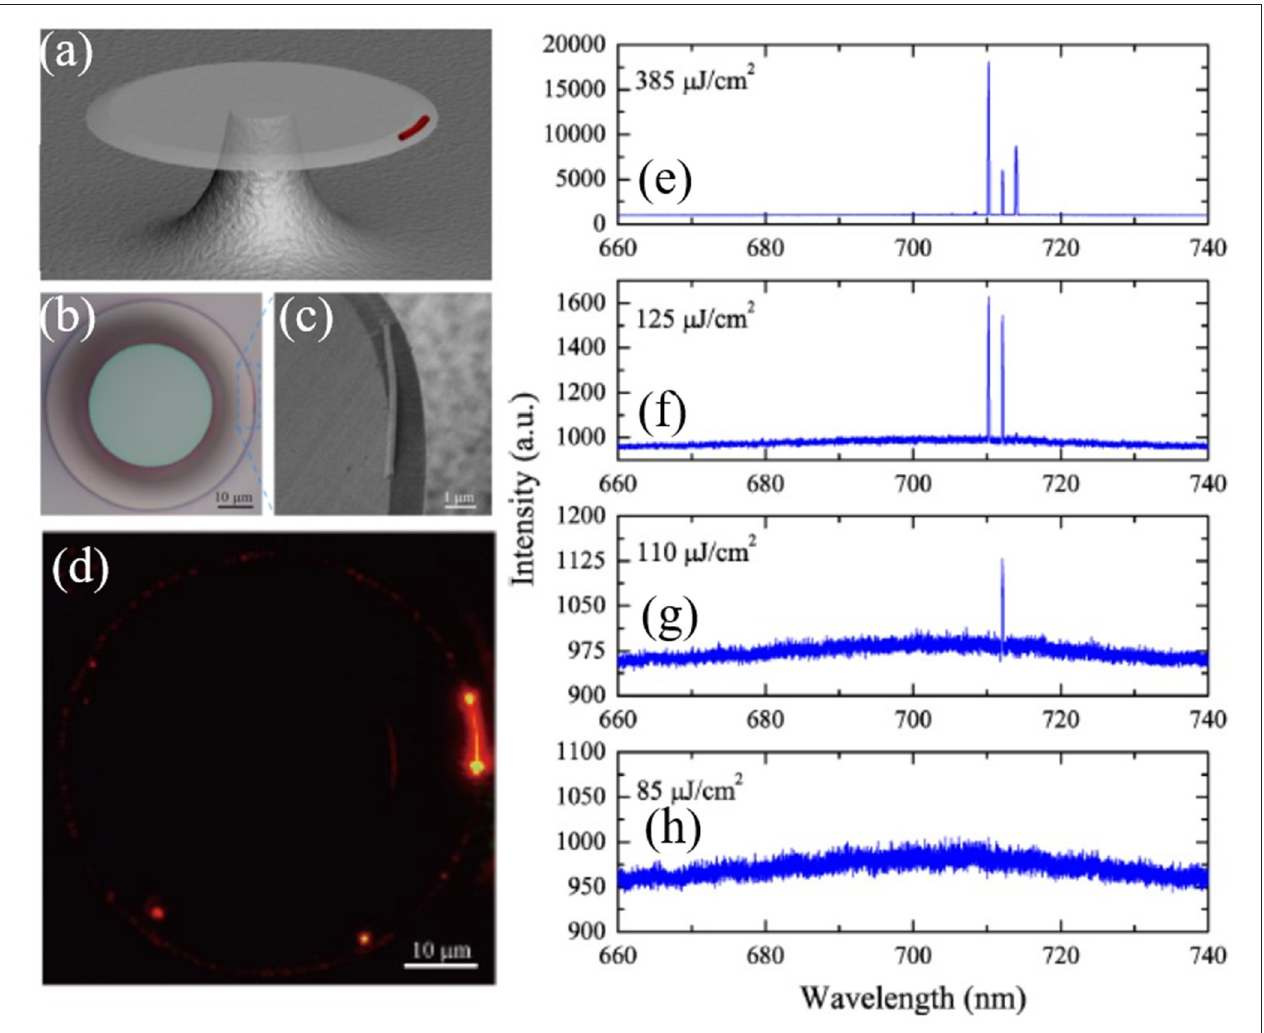
FIGURE 14 | (a) Schematic of the hybrid structure consisting of a nanowire and microdisk. (b) Optical microscope image of the hybrid structure. (c) SEM image of the hybrid structure. (d) PL image of the hybrid structure above lasing threshold. (e–h) Measured spectra of the hybrid cavity under different pumping powers. (a–h) Reproduced with permission. Wang et al. (2012) Copyright 2012, Optical Society of